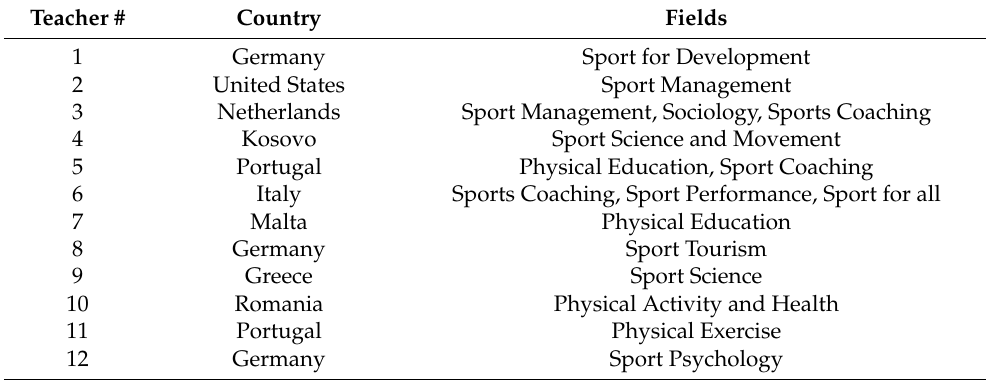
Table 2. Overview of teacher